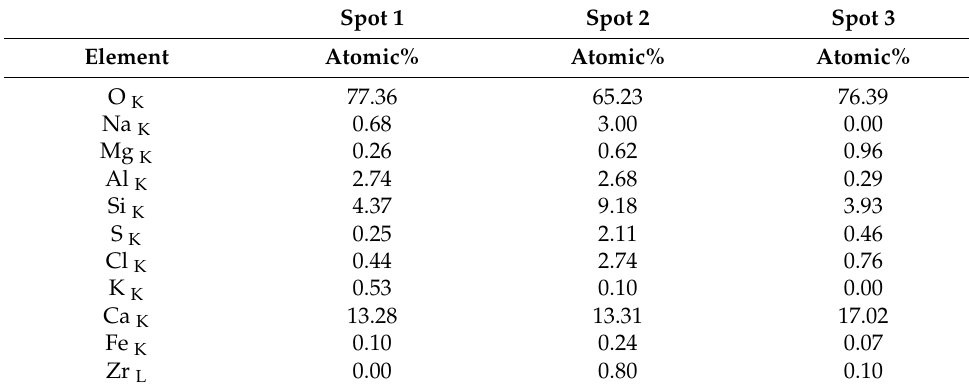
Figure 9. SEM micrographs of the fibers in the control GRC composite subjected to wetting–drying test with 3.5% NaCl. Table 5. Chemical analysis (energy dispersion spectroscopy, K and L EDS lines) of hydrated cement paste for control GRC subjected to a wetting–drying test with 3.5% NaCl (see spot numbering in Figure 9).